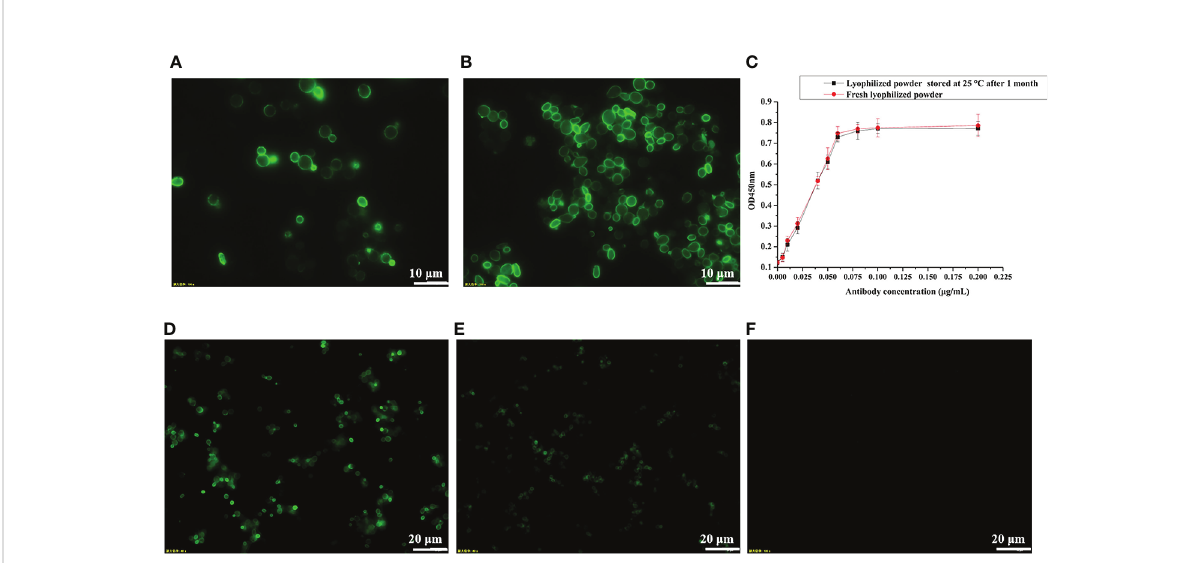
FIGURE 3 Determination of protein stability by immuno fl uorescence microscopy and ELISA. (A) pYD1-RBD/EBY200 before heat inactivation. (B) pYD1- RBD/EBY200 after heat inactivation. (C) Determination of protein stability of lyophilized yeast powder at 25°C for 1 month by ELISA. (D) Fresh lyophilized yeast powder at 4°C after 3 days. (E) Lyophilized yeast power at 4°C after 10 months. (F) Fresh lyophilized yeast powder with empty vector